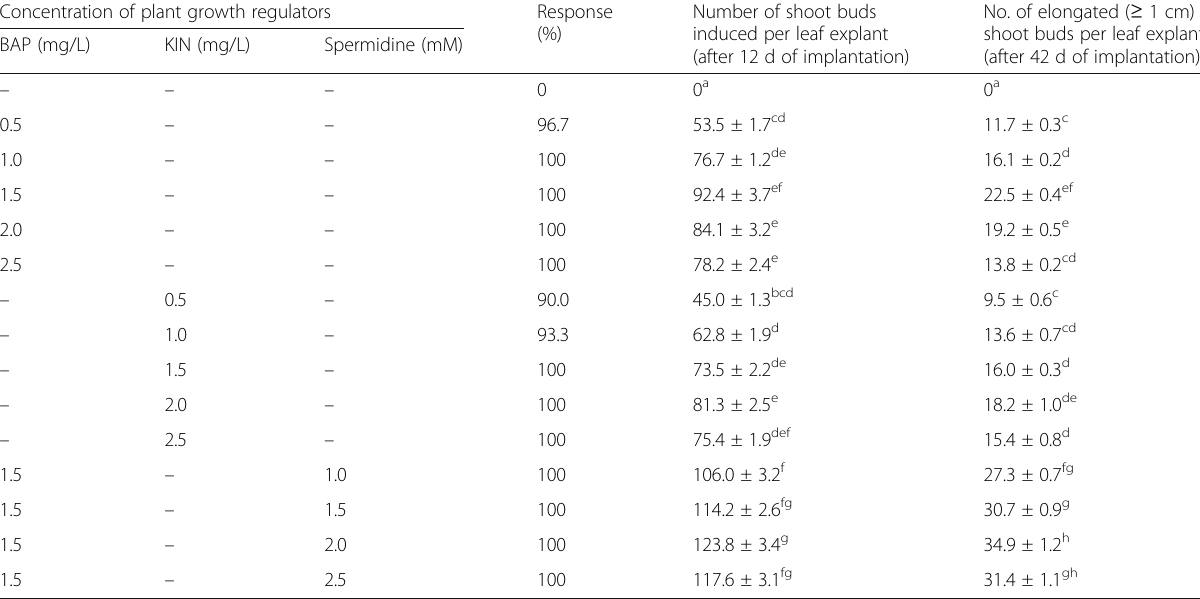
Table 2 Effect of two different cytokinins supplemented with MS basal medium and culture duration (i.e., regeneration cycles) on adventitious shoot induction from leaf explant of Bacopa monnieri Concentration of plant growth regulators Response implantation)BAP (mg/L) KIN